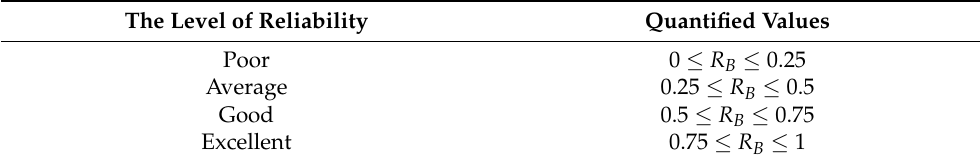
Table 3. The quantification of reliability